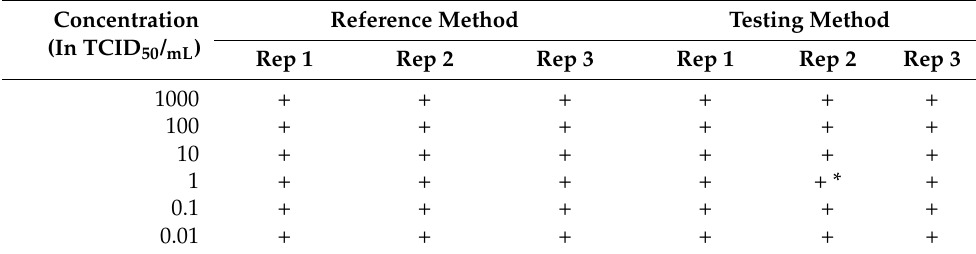
Table 2. Limit of detection for the Reference method and the Testing